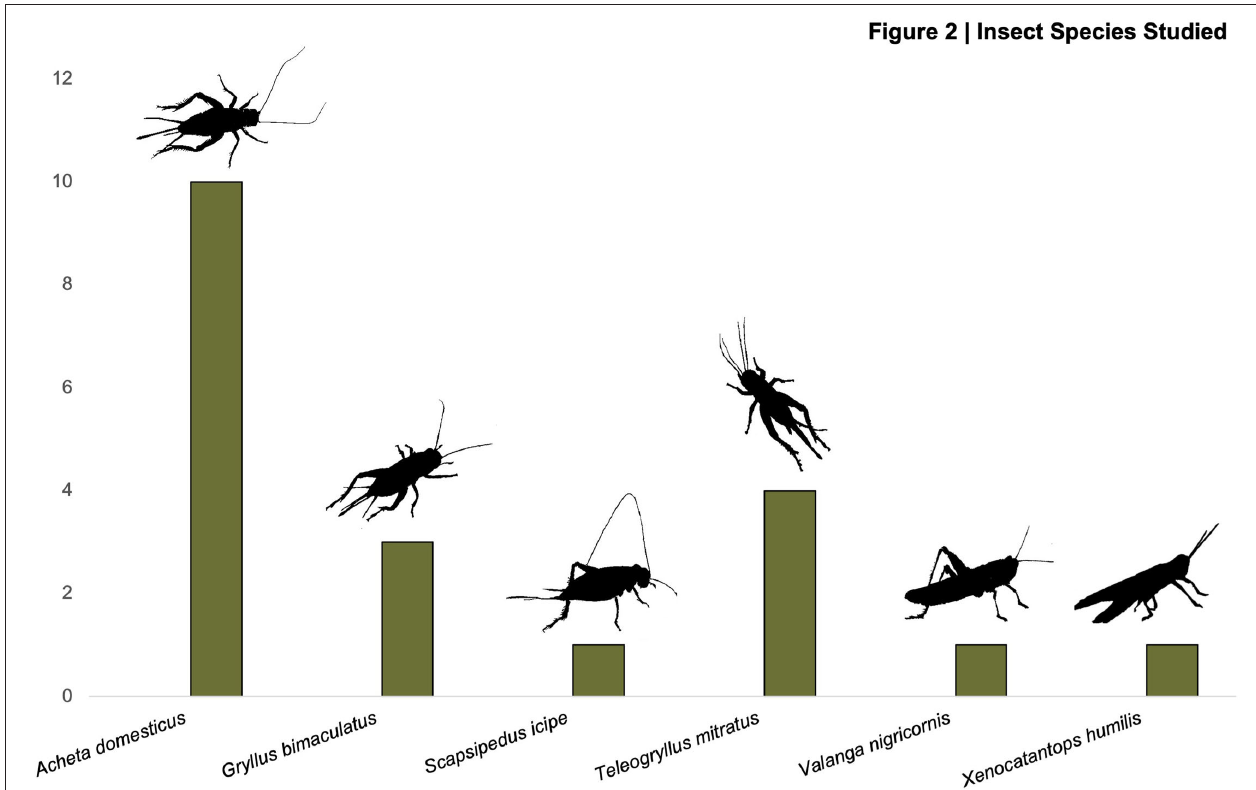
FIGURE 2 | Frequency of Orthoptera species across studies.